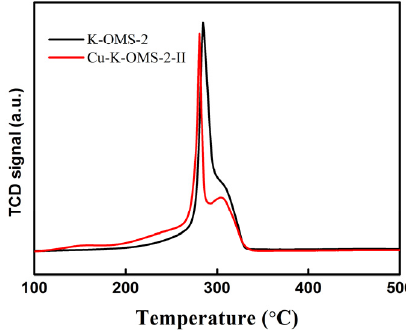
Figure 7. Temperature-programmed reduction (TPR) profiles of K-OMS-2 and Cu-K-OMS-2-II.